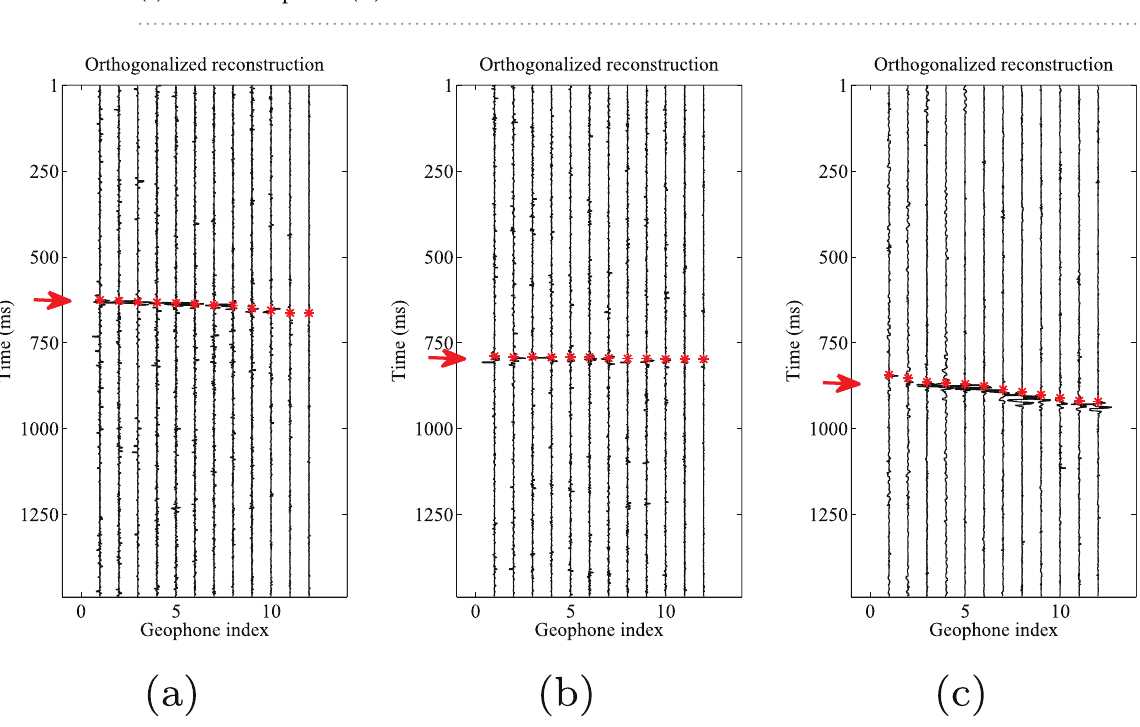
Figure 13. Arrival picking of orthogonalized morphological reconstructions. ( a ) Horizontal component (H1). ( b ) horizontal component (H2). ( c ) Vertical component